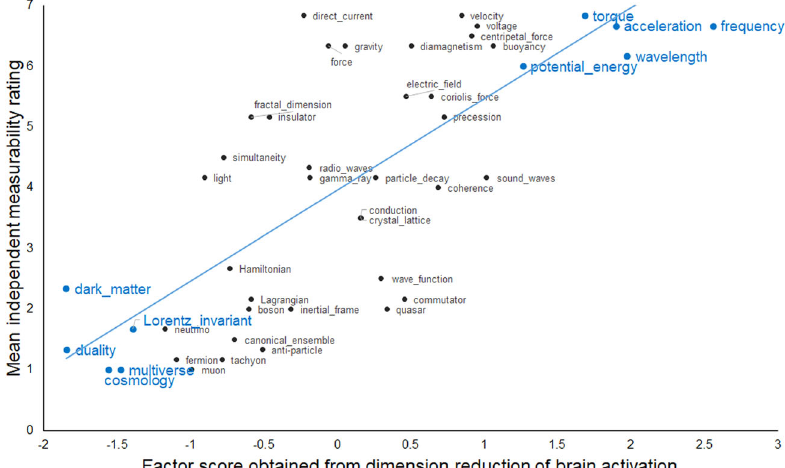
Fig. 2 Factor scores for the measurable magnitude factor from the fMRI brain data ( x -axis) were well correlated ( r = 0.74) with the mean expert ratings of the concepts with respect to that factor ( y -axis). The concepts at the extreme ends of the factor score distribution that are in fl uential for factor interpretation are highlighted in blue in a larger